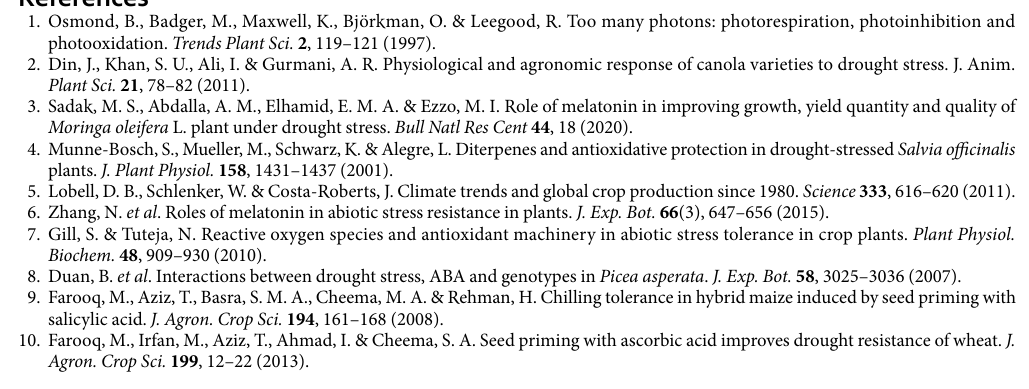
Hierarchical cluster analysis.